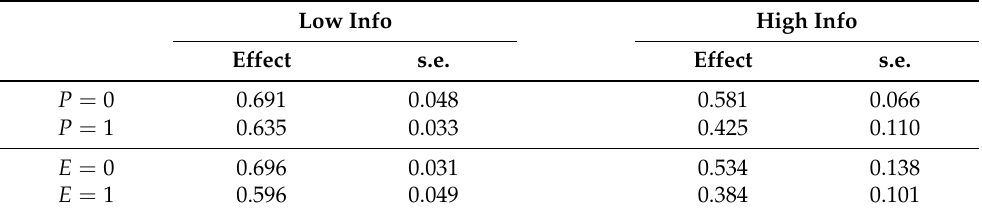
Table 3. Asks’ sensitivity to extreme values: The δ parameter across experimental groups. Low Info High Info Effect s.e. Effect s.e. P = 0 0.691 0.048 0.581 0.066 P = 1 0.635 0.033 0.425 0.110 E = 0 0.696 0.031 0.534 0.138 E = 1 0.596 0.049 0.384